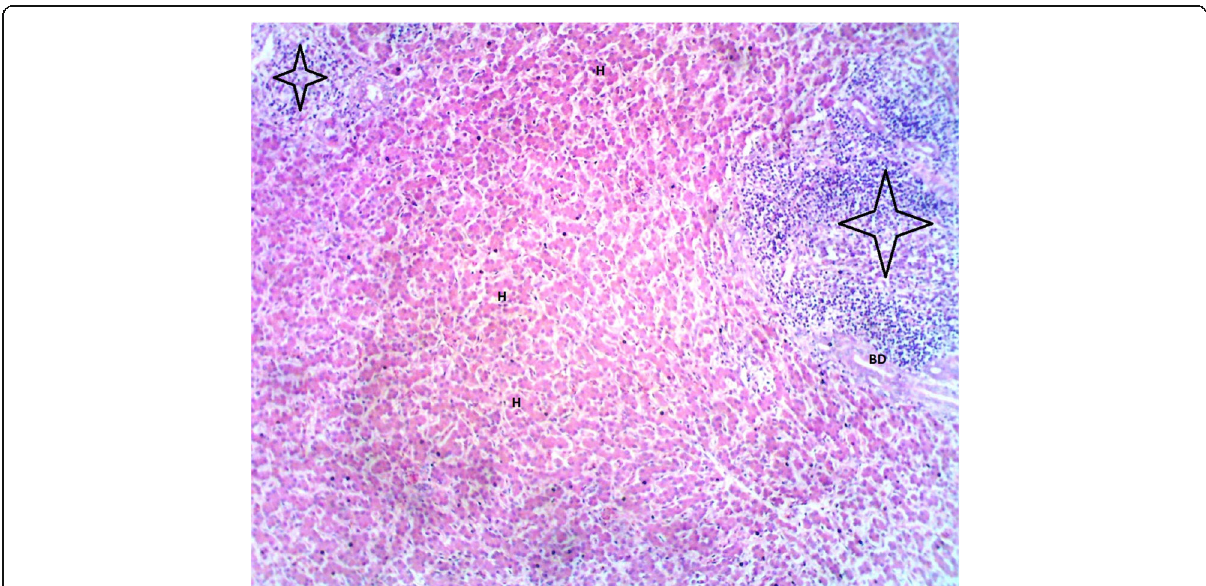
Fig. 3 Representative micrograph of liver section (× 400) of broiler chicks fed 0.4% PCM supplemented diet. This section shows liver parenchymal